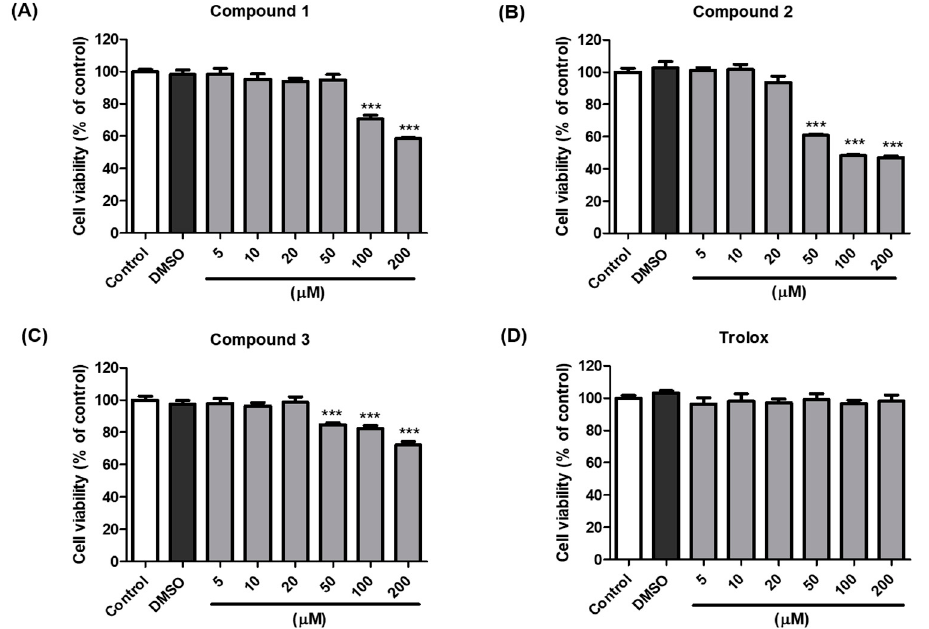
Figure 4. Effects of compounds 1 – 3 and trolox on the viability of B16F10 cells. Cells were incubated with different concentrations (5–200 µ M) of compound 1 ( A ), 2 ( B ), 3 ( C ), and trolox ( D ) for 48 h, and cell viability was determined using EZ-Cytox assay. *** p < 0.001 vs. DMSO-treated.